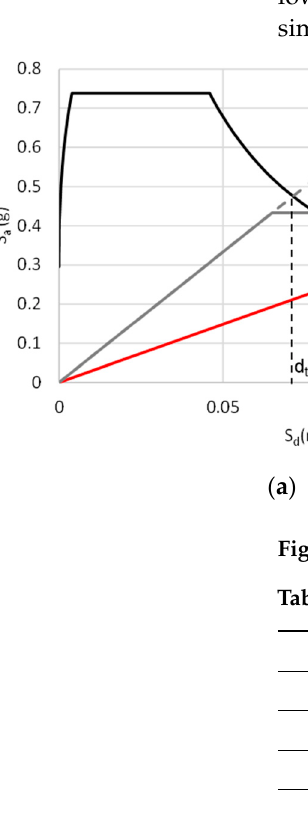
Table 15. Comparison of target displacements and average maximal displacements.